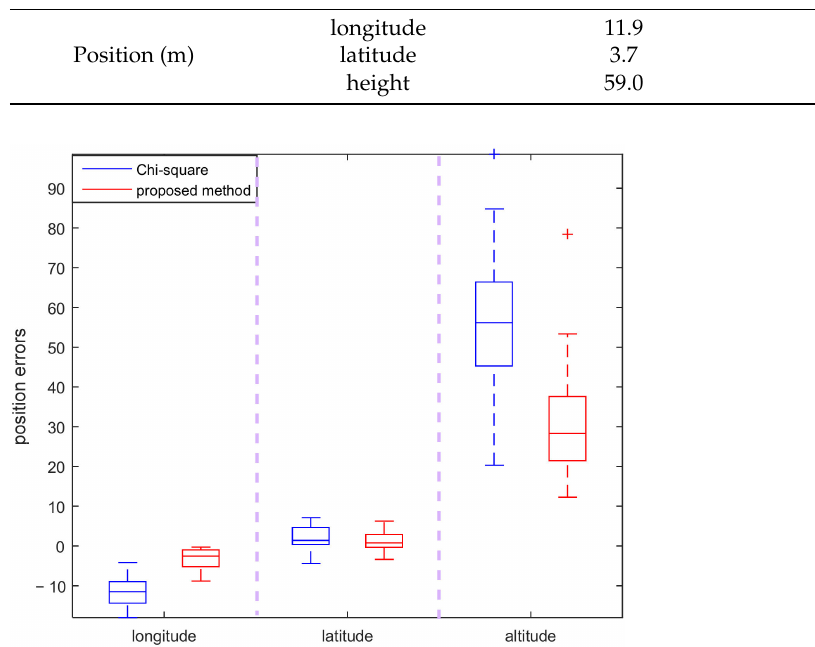
Figure 14. The box diagram of fused position errors obtained by the dataset UrbanNav-HK